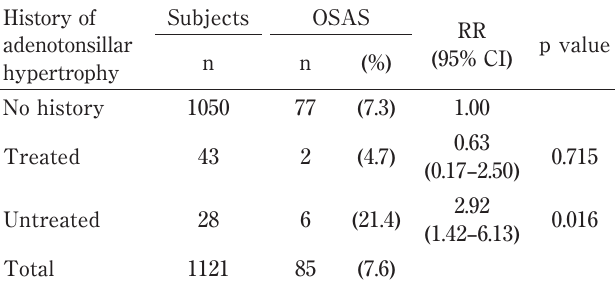
Table 2. Relative risks and 95% confidence intervals for OSAS associated with a history of adenotonsillar hypertrophy in Japanese male factory